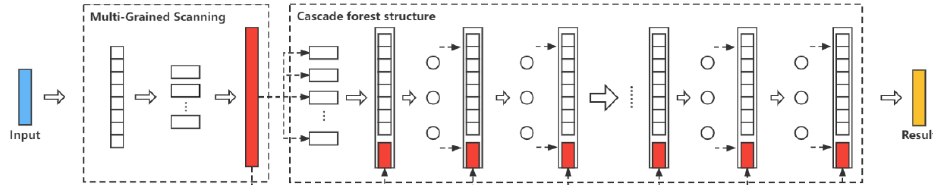
Figure 2. Structure of deep forest.